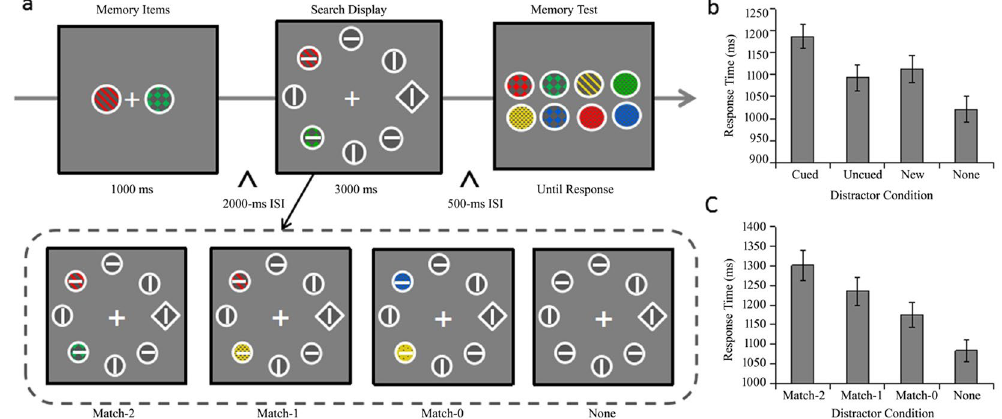
Figure 5. Trial sequences and results for Experiment 5. ( a ) The sequence of events with four possible distractor conditions in a trial of the two memory items condition (Match-2, Match-1, Match-0 and None distractor condition). ( b ) RTs for the search task as a function of distractor condition in the memory 1 item condition. ( c ) RTs for the search task as a function of distractor condition in the two memory items condition. Error bars indicate ± 1